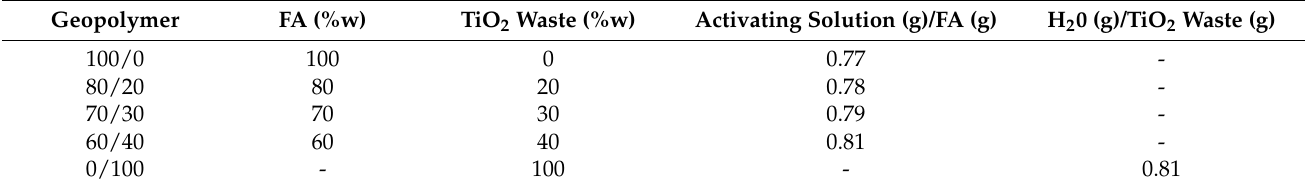
Table 3. Mix design of